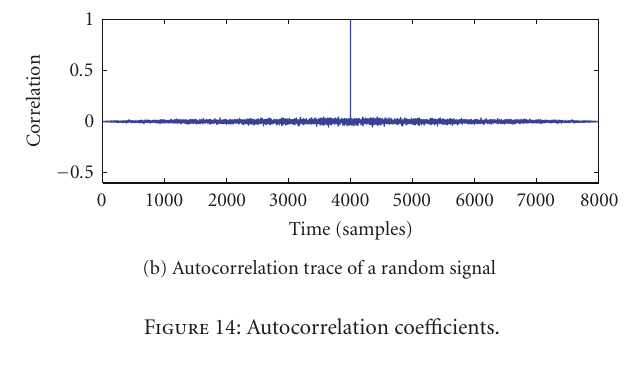
Figure 14: Autocorrelation coe ffi cients.